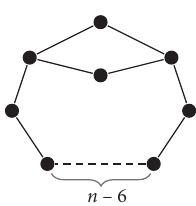
Figure 6: The bicyclic graph Θ